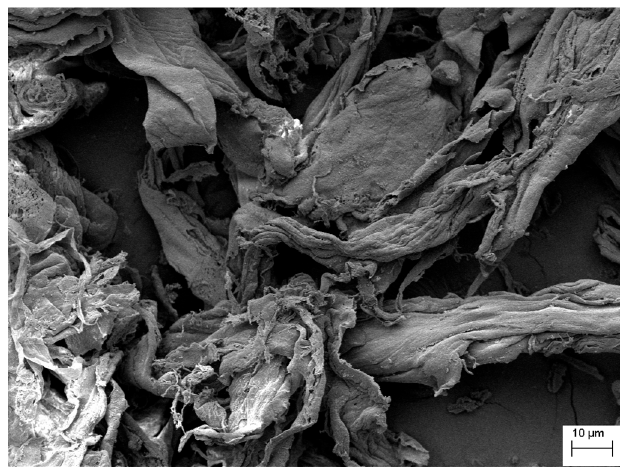
Figure 6. SEM image of CTA-LU.